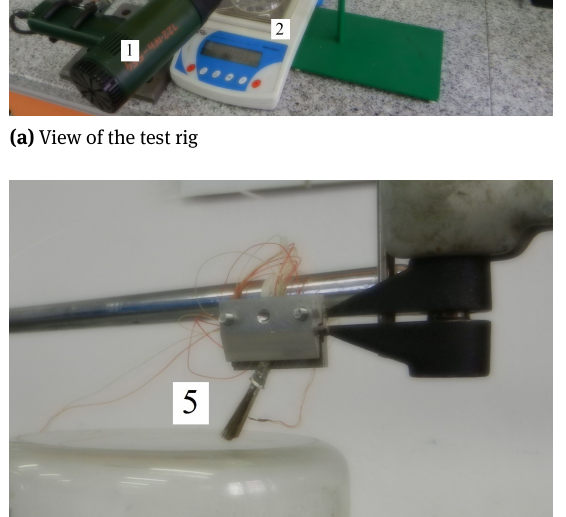
Figure 4: Test rig for determination of force of a concept brush seal with bimetal as a function of interferance and temperature